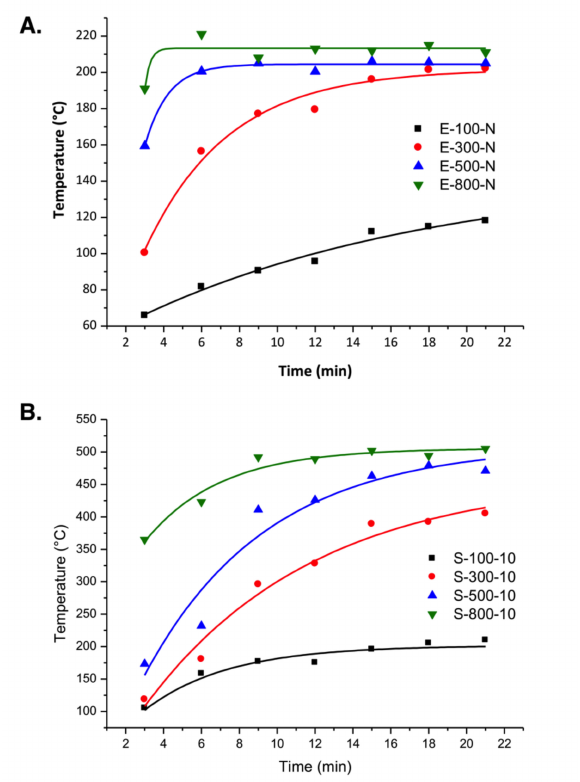
Figure 2. Real-time temperature profiles of the PWS samples. ( A ) 1st category of samples. ( B ) 2nd category of samples.